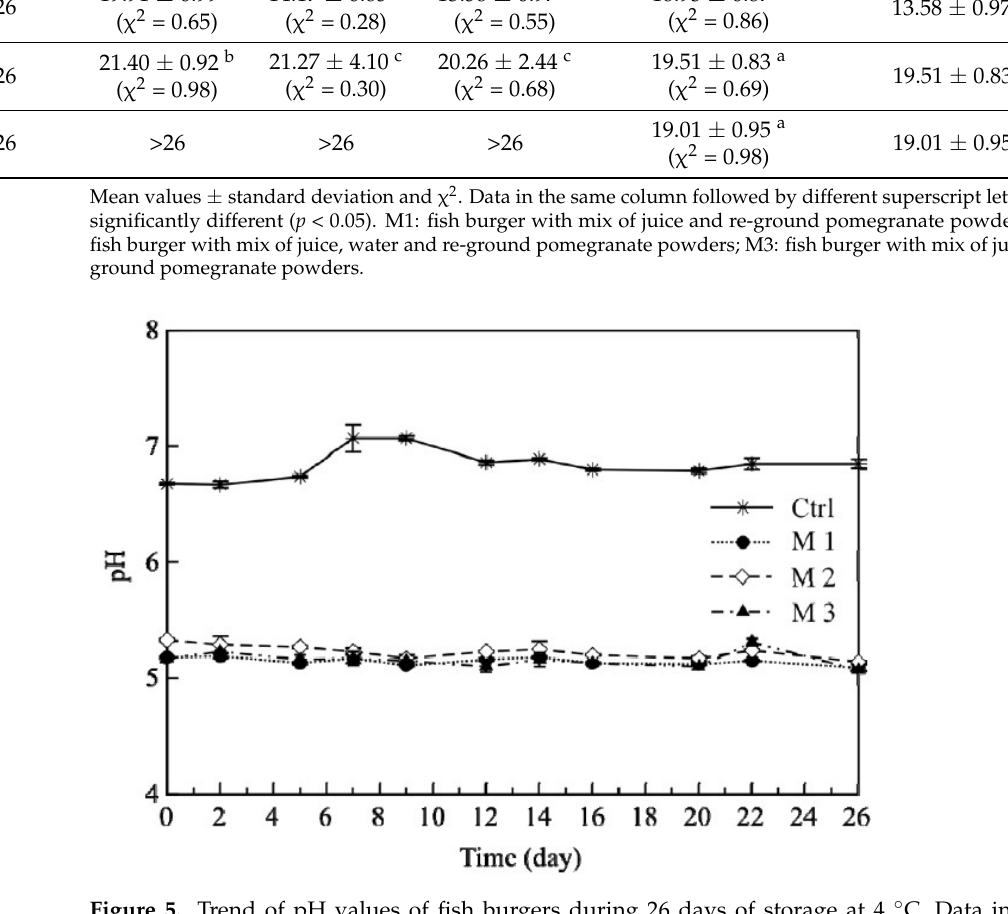
Figure 5. Trend of pH values of fish burgers during 26 days of storage at 4 °C. Data indicate means ± SD. Ctrl: fish burger; M1: fish burger with mix of juice and re-ground pomegranate by-products; M2: fish burger with mix of juice, water and re-ground pomegranate by-products; M3: fish burger with mix of juice and ground pomegranate by-products.